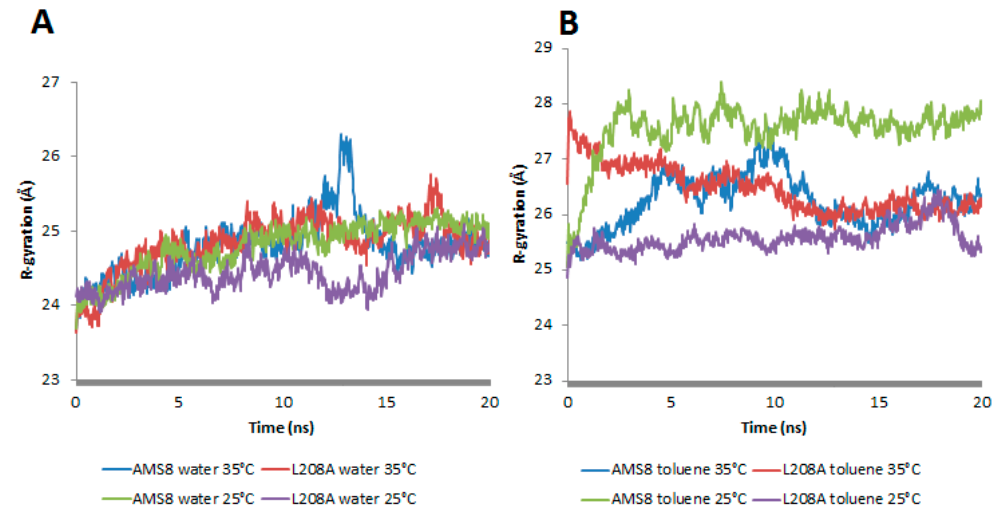
Figure 1. The radius of gyration, Rg (measure of the mass-weighted spatial distribution of the atoms in a peptide molecule/protein and a rough measure for its compactness) in WT AMS8 and mutant L208A in water—( A ) and toluene—( B ) (at 25 °C and 35 °C) respectively.